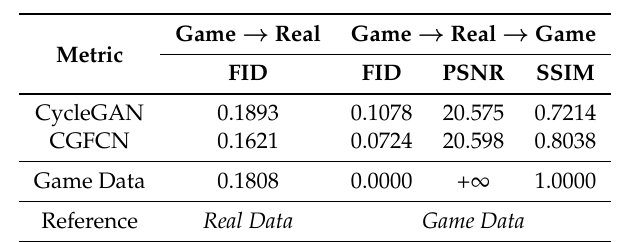
Table 5. Evaluation results on image style transfer results with different similarity evaluation